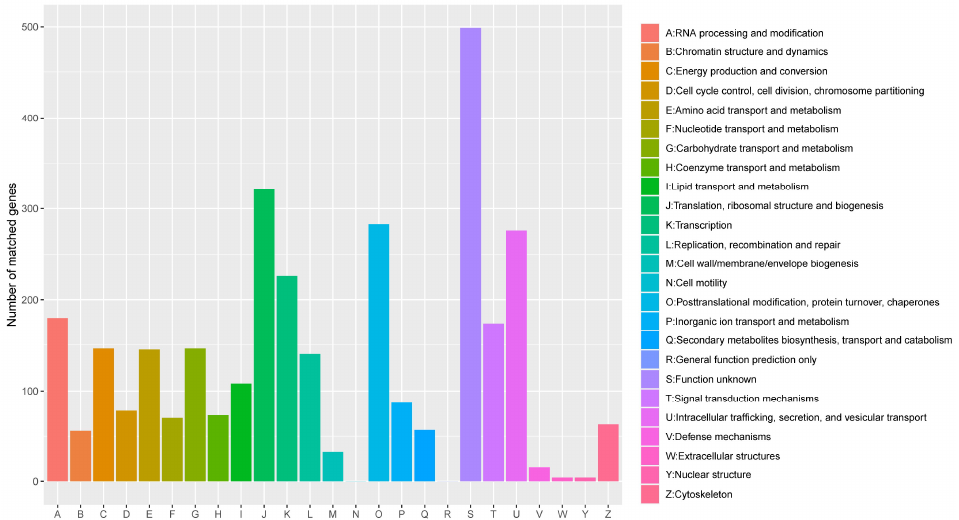
Figure 3. eggNOG functional classification diagram.